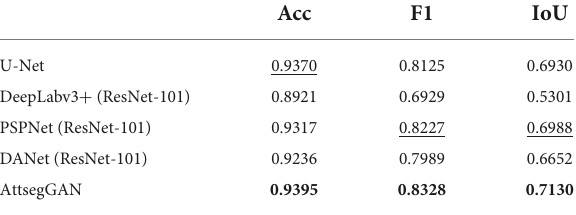
TABLE 4 Statistics of comparative experiment results on Massachusetts building dataset.